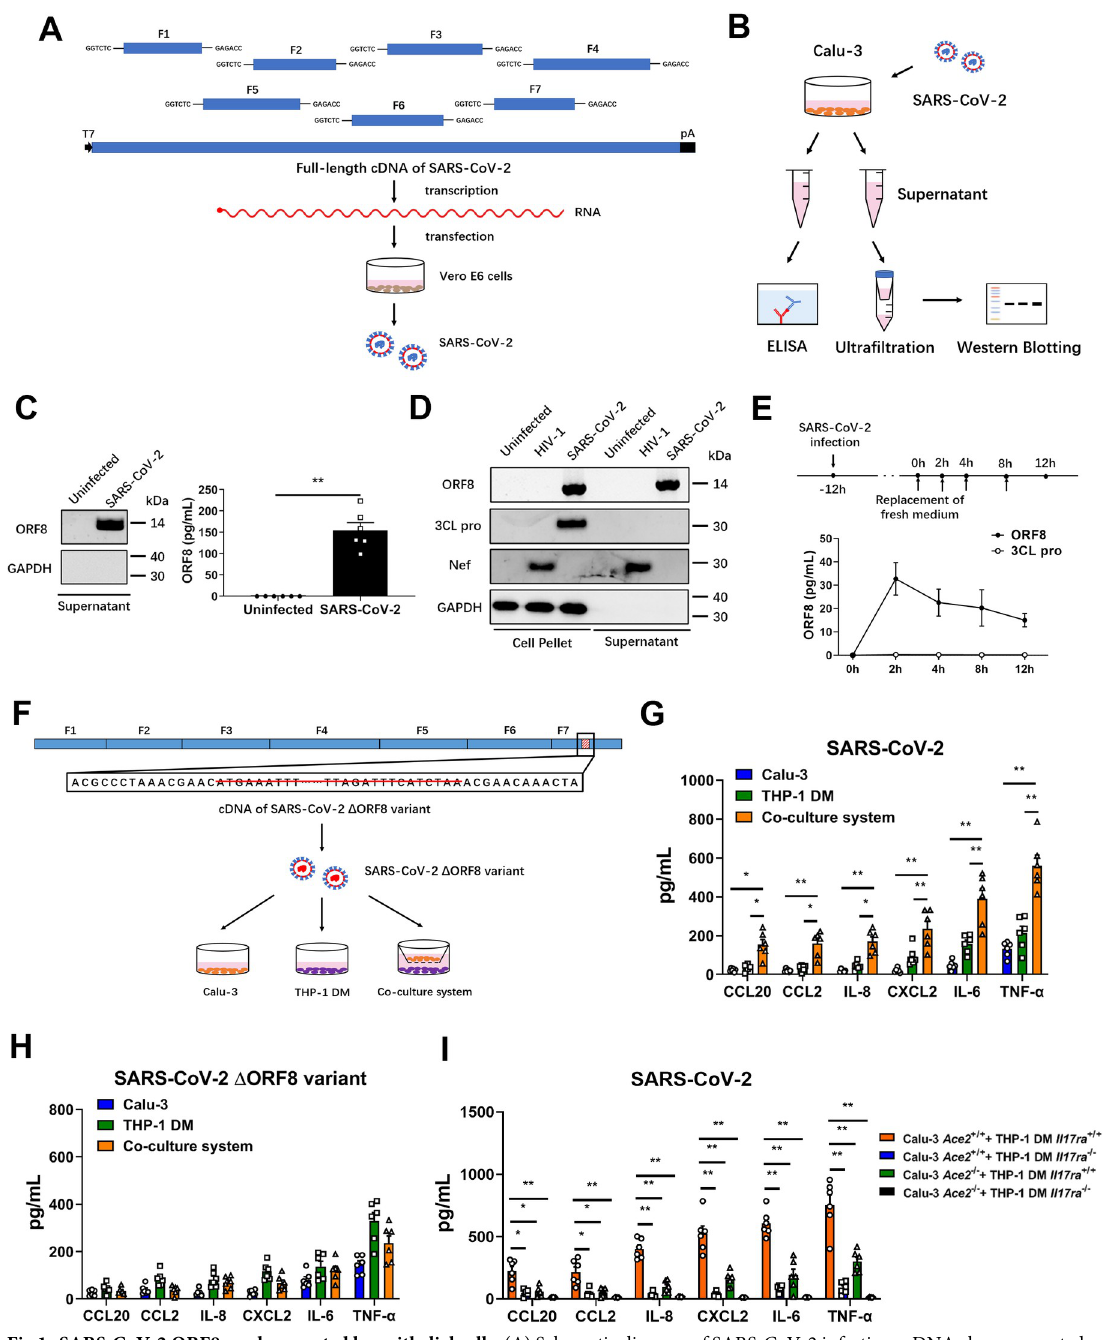
Fig 1. SARS-CoV-2 ORF8 can be secreted by epithelial cells. (A) Schematic diagram of SARS-CoV-2 infectious cDNA clone generated by a reverse genetic system. The cDNA fragments F1-F7 were synthesized and assembled into full-length SARS-CoV-2 cDNA, and RNA transcription, electroporation, and virus production were carried out in Vero E6 cells. (B) Schematic diagram of SARS-CoV-2 infection model. Calu-3 epithelial cells were infected with SARS-CoV-2 at a MOI of 0.01. After 12 hours, cell culture supernatant was centrifuged and divided into two parts for western blotting and ELISA, respectively. (C) The secretion of ORF8 in (B) was detected by western blotting and ELISA. (D) Jurkat cells or Calu-3 epithelial cells were infected with HIV-1 or SARS-CoV-2. After 12 hours, the secretion of ORF8, Nef and 3CL pro was detected by western blotting. (E) Schematic diagram of time-dependent ORF8 secretion upon SARS-CoV-2 infection. Twelve hours after SARS-CoV-2 infection, cell culture medium was replaced, and the amount of ORF8 protein in the supernatant was detected by ELISA every 2 hours. (F-H) Schematic diagram of ORF8-deleted SARS-CoV-2 variant (F). ORF8 coding sequence was deleted from the cDNA of F7 fragment. SARS-CoV-2 Δ ORF8 variant was used to infect Calu-3 cells, THP-1 DM cells, and the co-culture system. The secretion of cytokines and chemokines related to cytokine storm was detected by ELISA (G, H). (I) Calu-3 Ace2 +/+ , Calu-3 Ace2 -/- ,